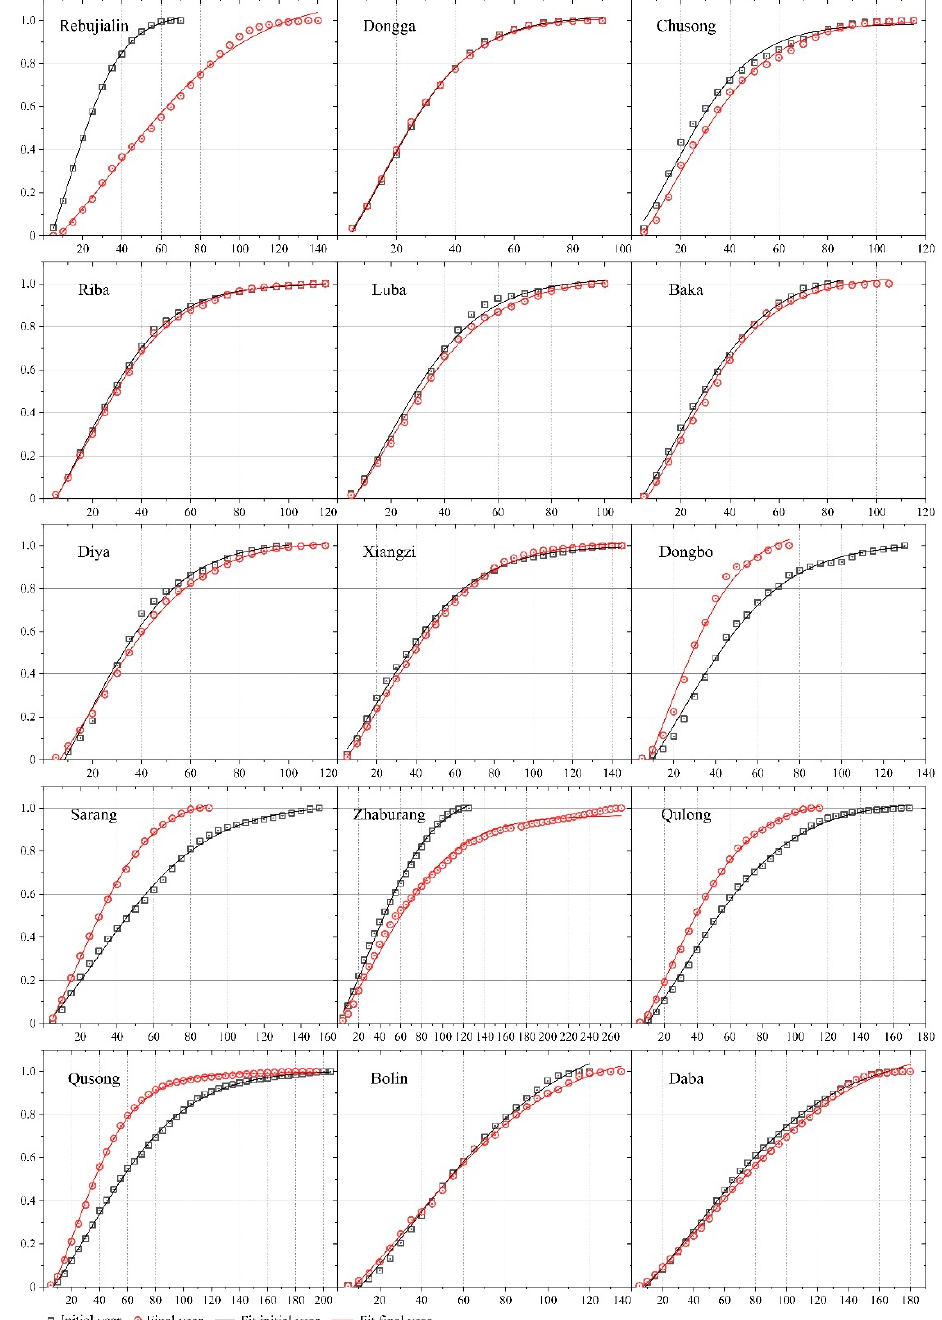
Figure 7. Graphs of the fitted rural settlement scale growth function.